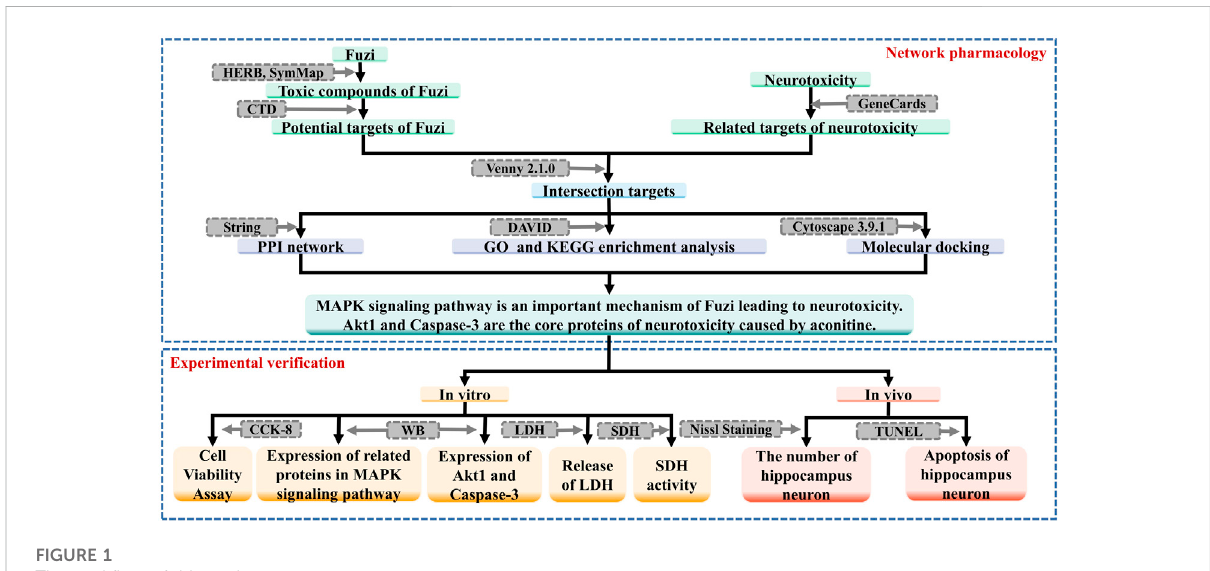
FIGURE 1 The work fl ow of this